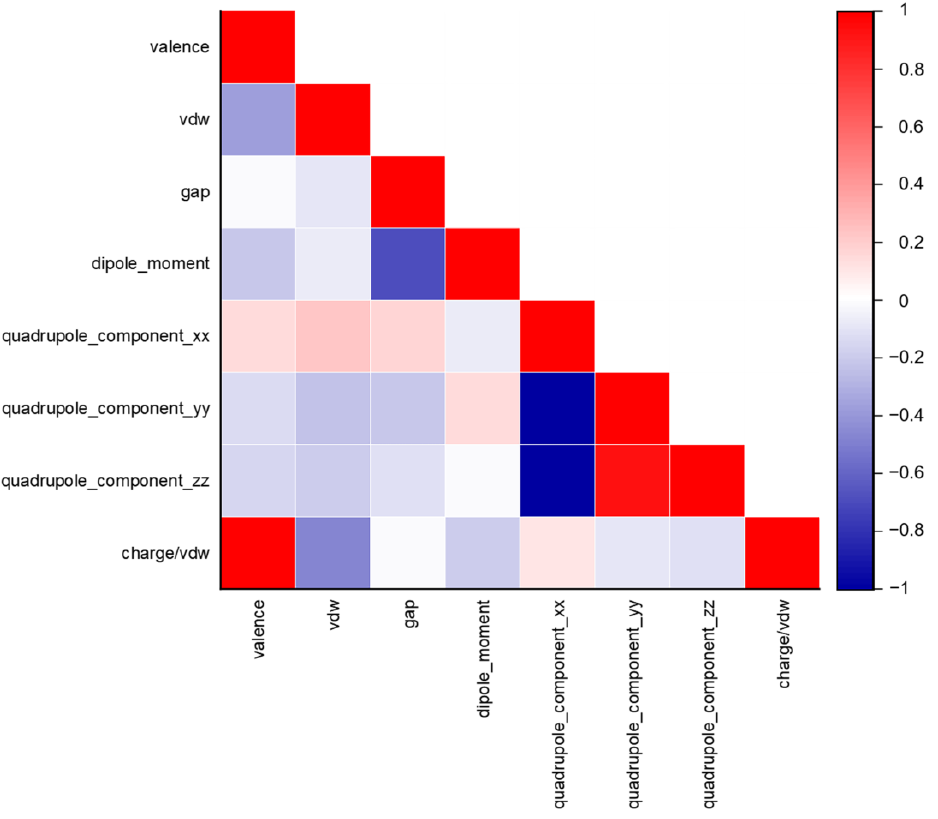
Figure 5. Pearson correlation matrix for values calculated (‘gap’—energy gap for sensor molecules; ‘dipole_moment’—dipole moment; ‘quadrupole_component_xx’, ‘quadrupole_component_yy’, ‘quadrupole_component_zz’—diagonal elements of the polarizability tensor; ‘charge/vdw’—polarizing ability of ions).